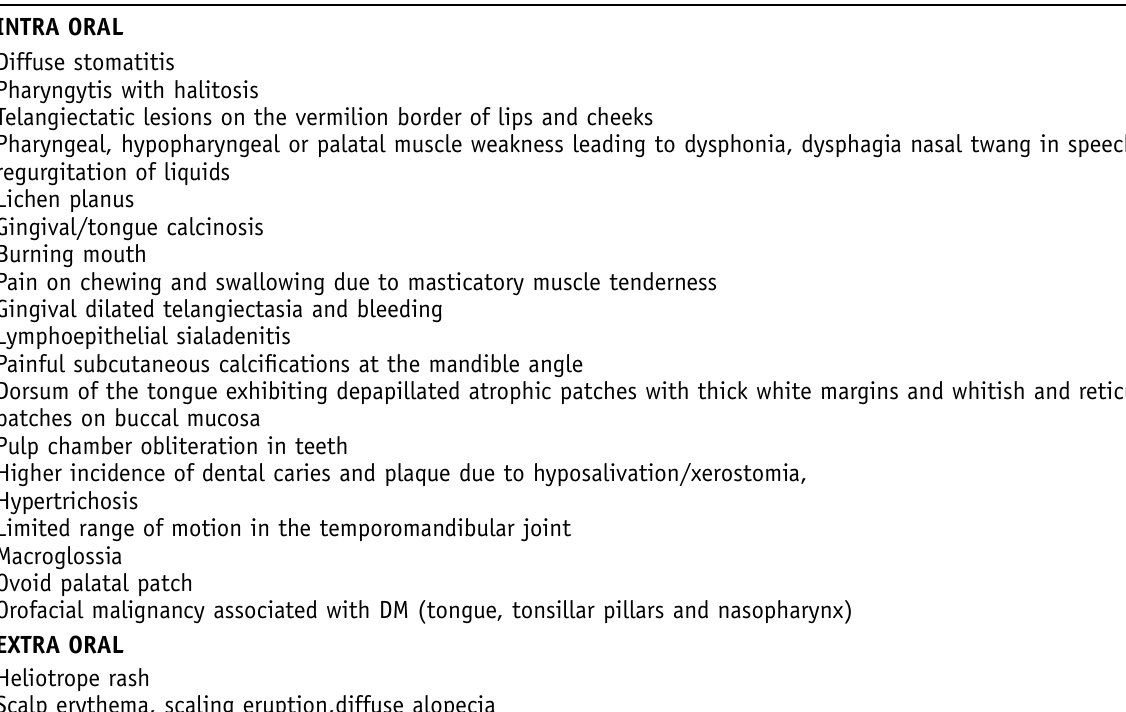
Table II. Orofacial manifestations of